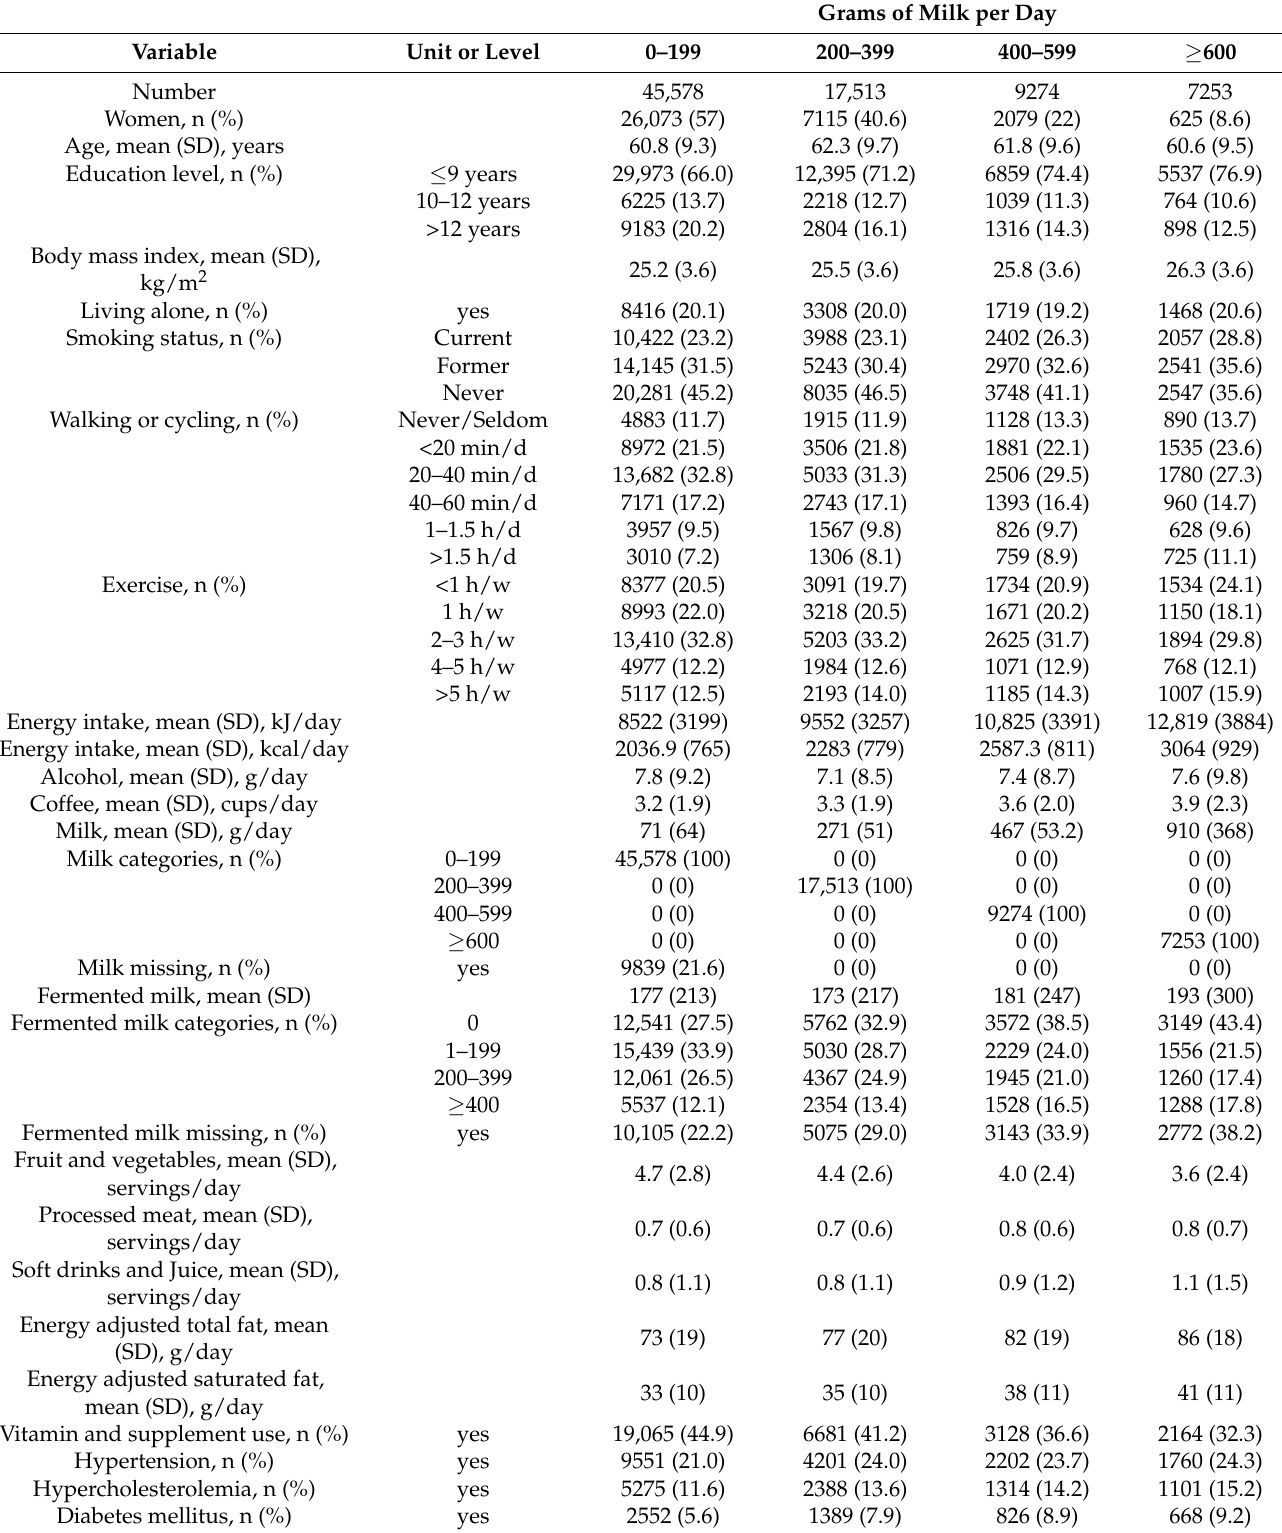
Table 1. Baseline characteristics in 1997 according to categories of milk consumption in the Swedish Mammography Cohort and Cohort of Swedish